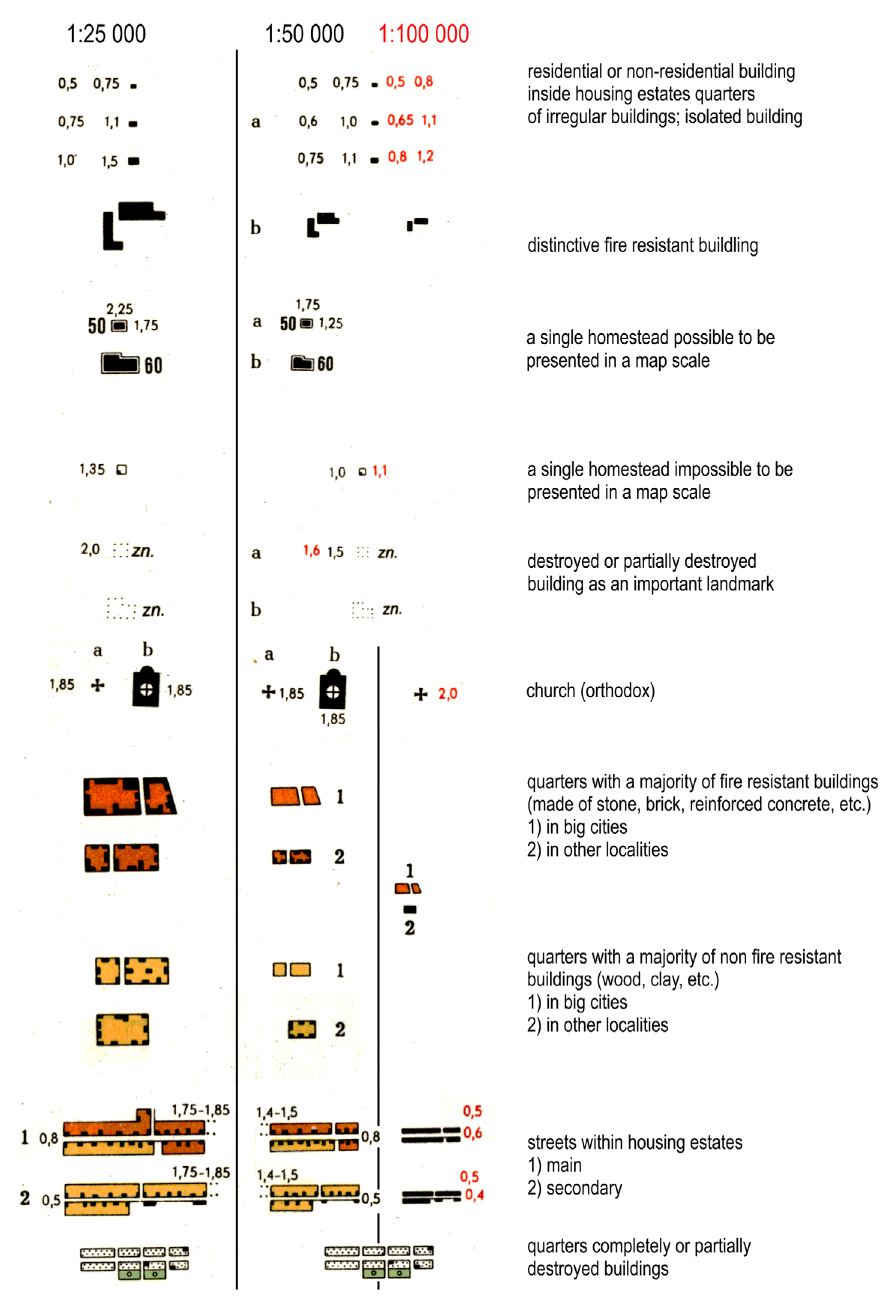
Fig. 2. A part of instructions for development of military maps at the scales of 1:25,000, 1:50,000 and 1:100,000: a – symbols of objects that cannot be represented on the map’s scale, b – symbols of objects that can be depicted at this